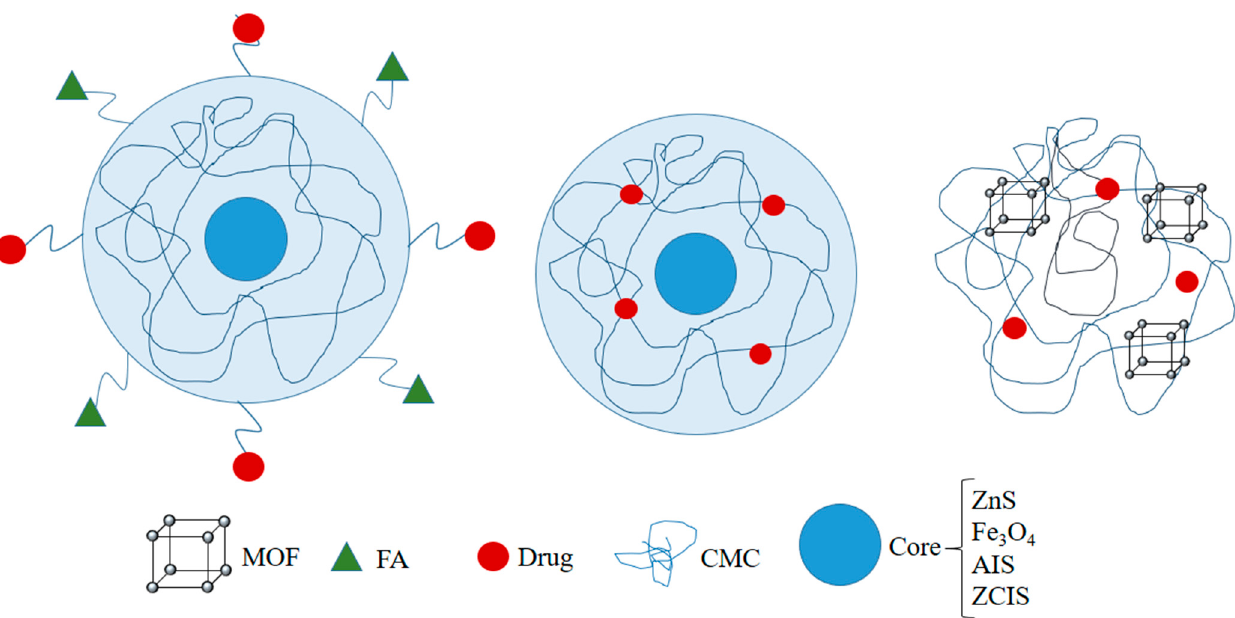
Figure 2 .A generalized structure of CMC ‐ containing